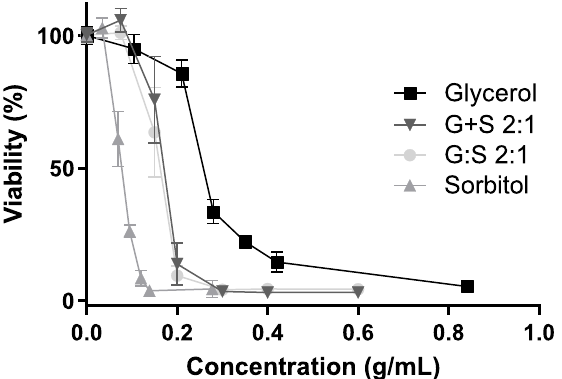
Figure 4. Cell viability (%) for different concentrations of glycerol (square), sorbitol (triangle), G:S 2:1 (circle), and G + S 2:1 (inverted triangle). No significant differences between the viability profiles G:S and G + S ( p -value > of G:S and G + S ( p -value > 0.8).